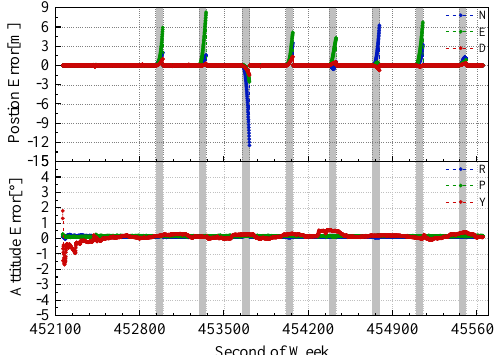
Figure 9. Position and attitude errors of the GNSS/INS/LiDAR-SLAM integrated navigation system in the GNSS outage simulation test #2.